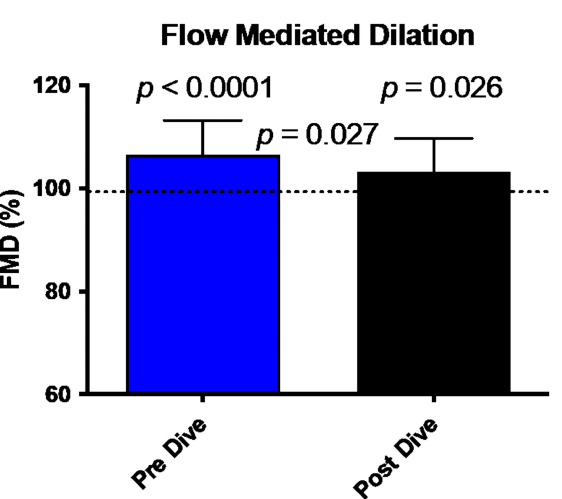
Figure 1. Bar graph illustrating the reduction of FMD 30 min post dive (black bar) compared to predive values (Blue Bar) (mean ± SD). ( N = 15).